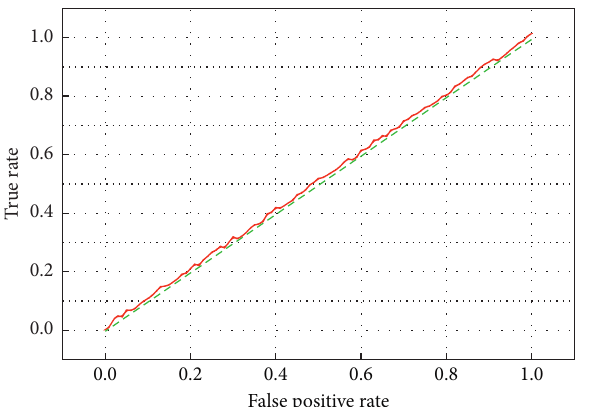
Figure 6: ROC curve with the main independent variables removed.